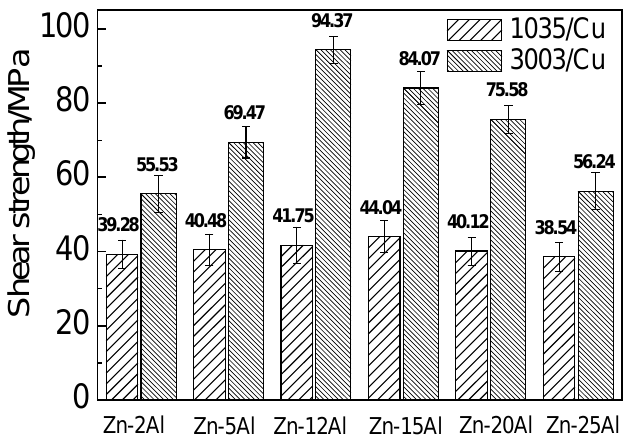
Figure 6. Shear strength of 3003 Al / Cu and 1035 Al / Cu joints brazed by the Zn-xAl filler Figure 6 . Shear strength of 3003 Al/Cu and 1035 Al/Cu joints brazed by the Zn-xAl filler metals .